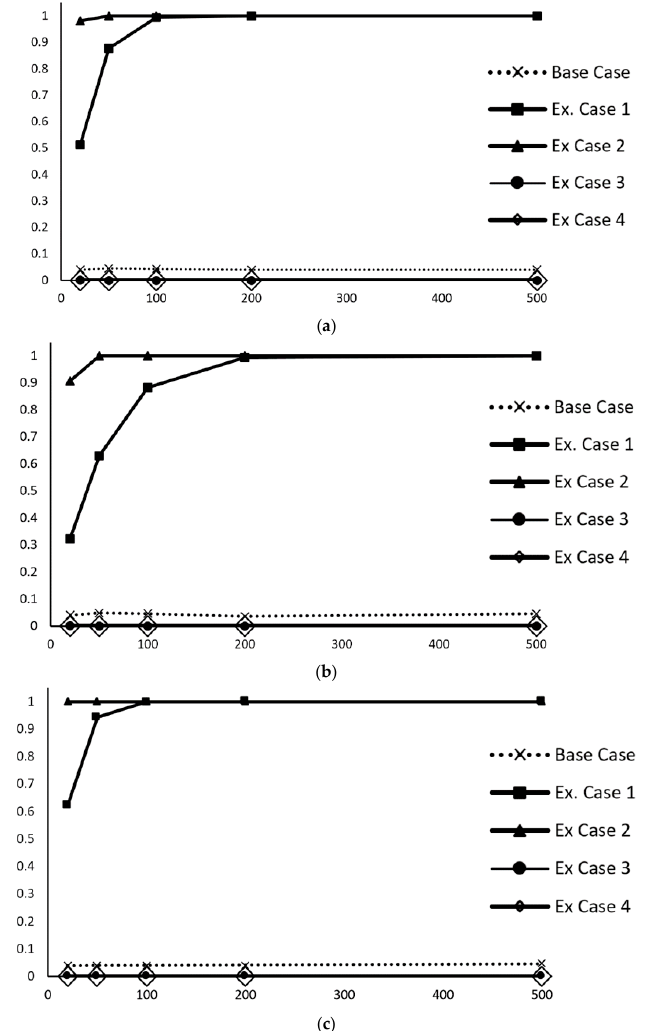
Figure 5. Proportion of times that the null hypothesis is rejected (type II error) for the sensitivity analysis of the 3rd quality control case: ( a ) infrastructure study case, ( b ) urban study case, and ( c ) natural study case.